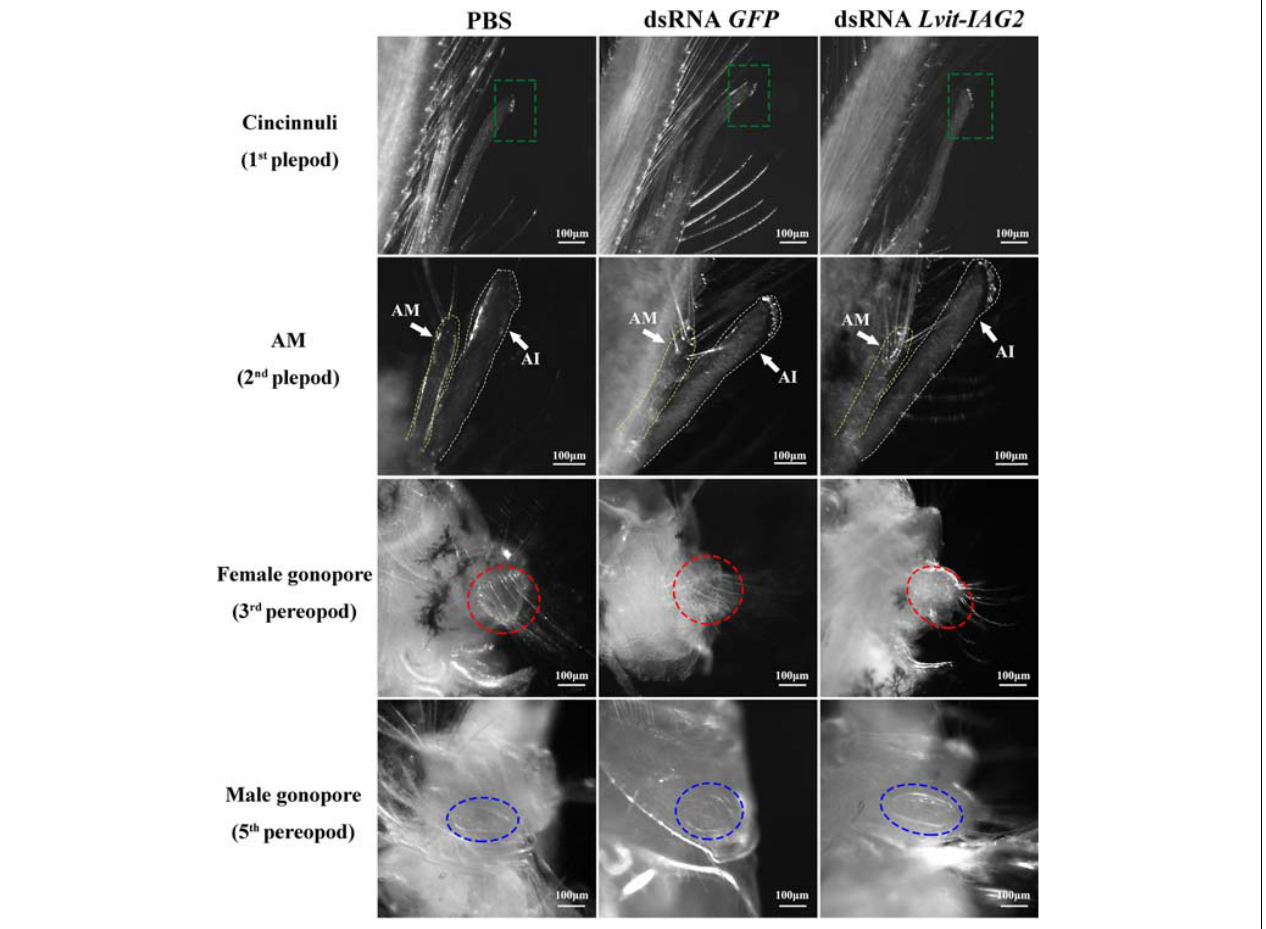
FIGURE 7 | Effects of Lvit-IAG2 silencing on development of male and female sexual characteristics. Both male (cincinnuli, AM, male gonopore) and female characteristics (female gonopore) were photographed at the end of the 30 day experiment. The AI was marked by white dashed lines, while the AM was marked by yellow dashed lines. Male and female gonopores were noted by blue and red dotted circle, respectively. AM, appendices masculinae; AI, appendix